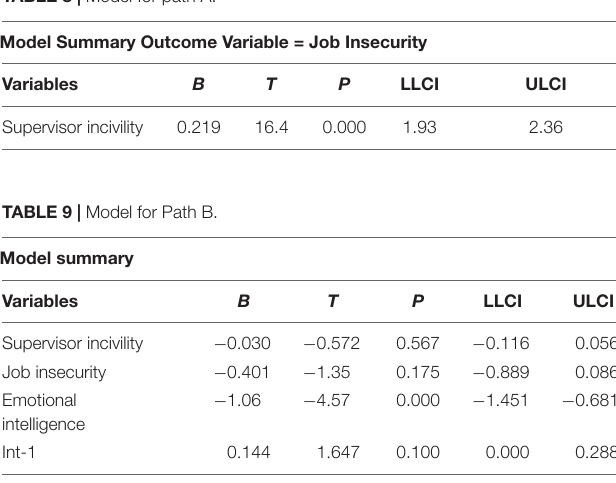
TABLE 8 | Model for path A.